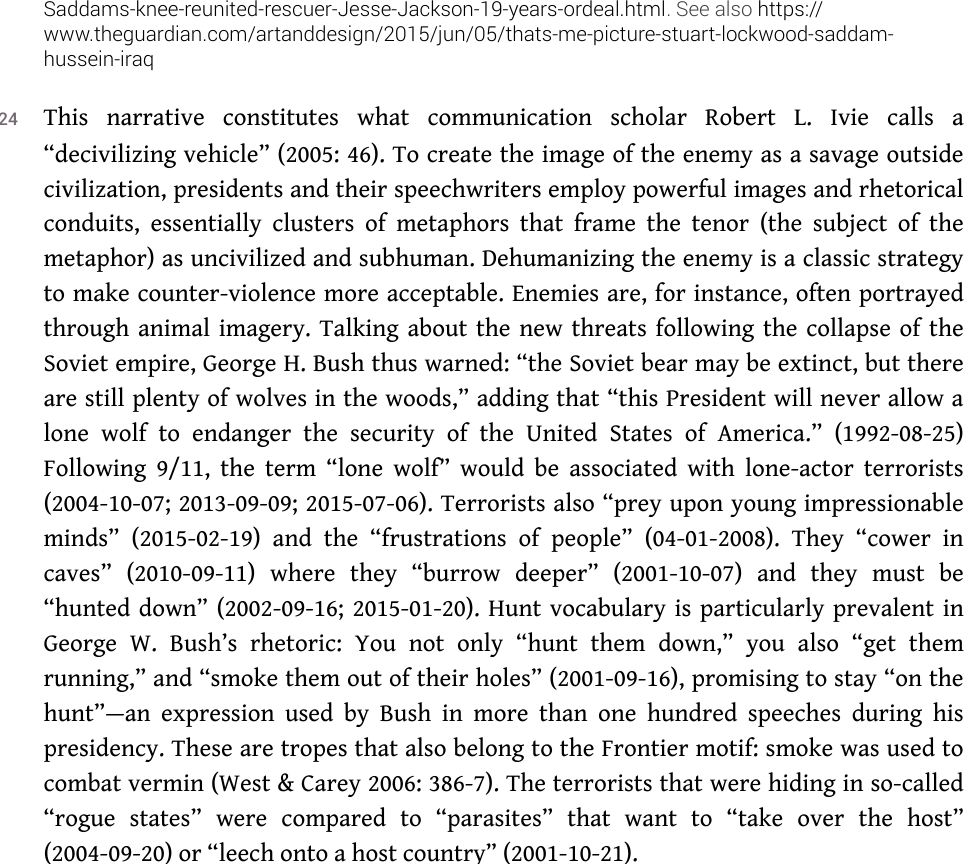
Source: https://www.dailymail.co.uk/news/article-1165186/British-child-hostage-refused-sit- Saddams-knee-reunited-rescuer-Jesse-Jackson-19-years-ordeal.html. See also